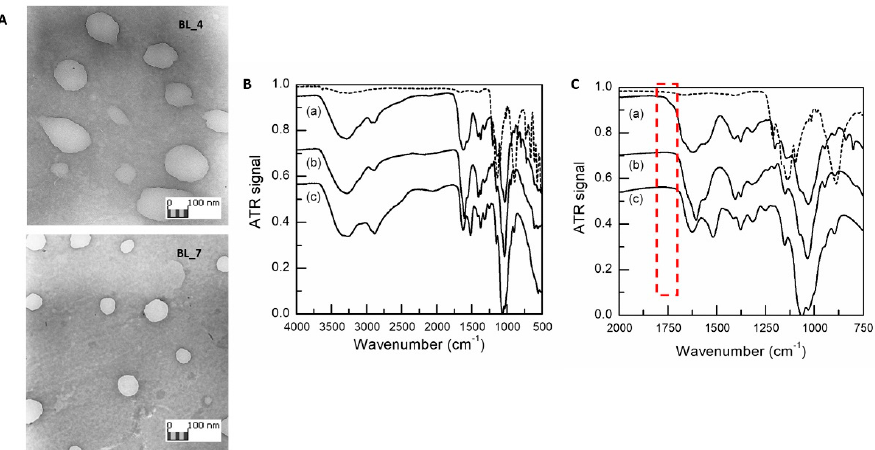
Figure 1. ( A ) TEM images of BL_4 and BL_7 samples (obj. mag. 20 k × ). ( B ) FTIR spectra from 500 to 4000 cm − 1 of sodium tripolyphosphate (TPP) raw material (dashed line), freeze dried HA/CS NPs (Et_CS_7) (a), HA raw material (b) and CS raw material (c); ( C ) Enlargement of the fingerprint region from 750 to 2000 cm − 1 . HA and CS spectrum have been shifted vertically by -0.2 and -0.45, respectively, to clarify viewing.